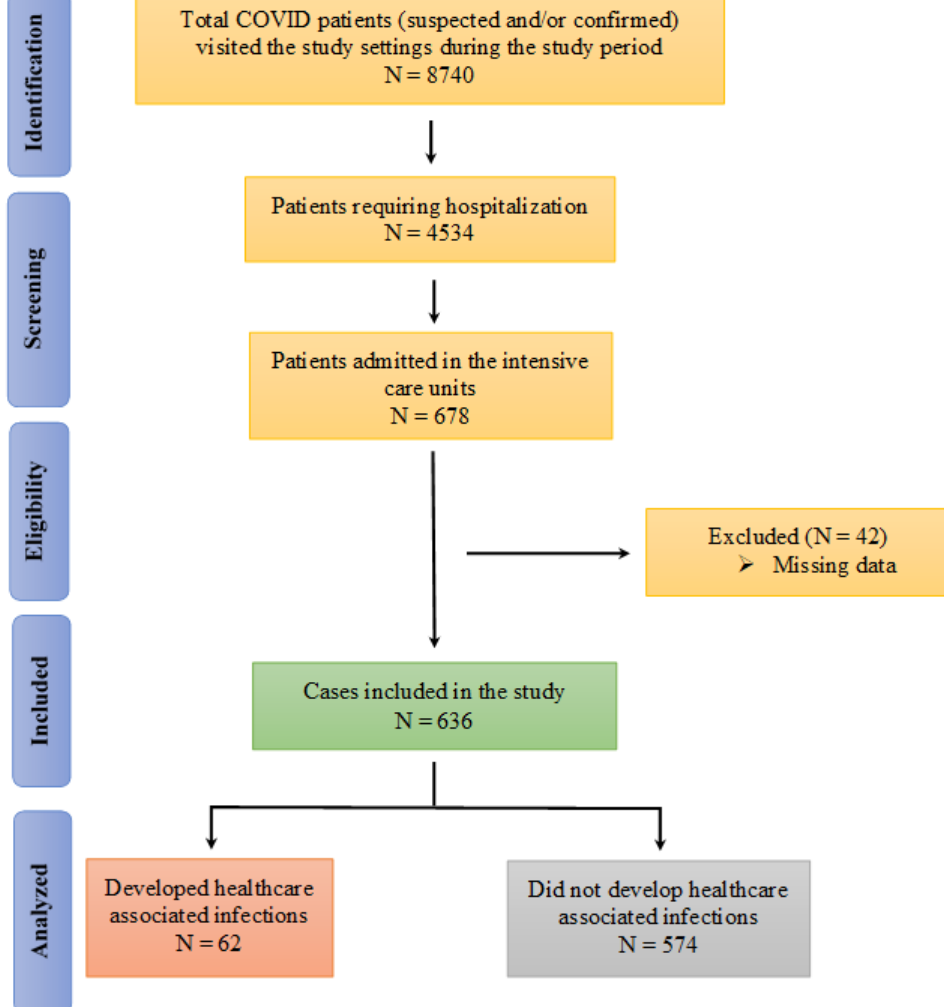
Figure 1. Flow diagram of the identification of the patients for inclusion in the study. A total of 67 HAIs from different microorganisms developed among the 62 patients with HAIs on the ICU giving a prevalence of 9.7%. Out of the 67 HAIs, 23 were ventilator- associated lower respiratory tract infections, 16 catheter-related urinary tract infections, 14 catheter-related blood stream infections, 12 blood infections of unknown origin and two were fungal infections (Figure 2).